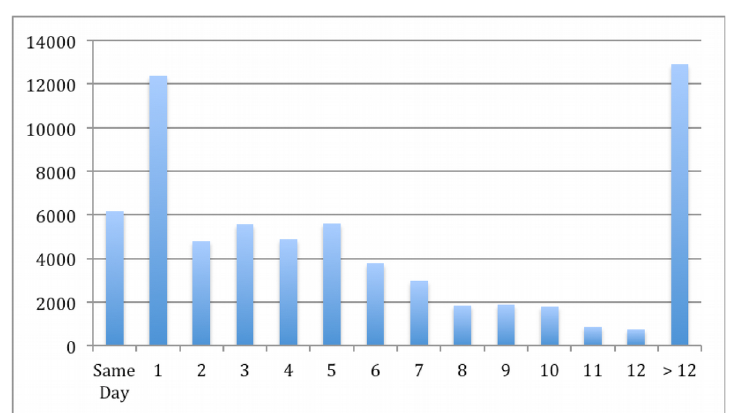
Figure 3. Plot of established patients’ appointment distribution by waiting